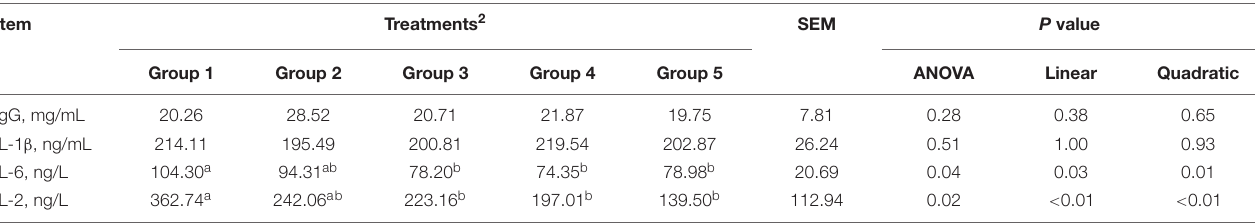
Table 3 . Serum levels of MDA ( P = 0.52) and SOD